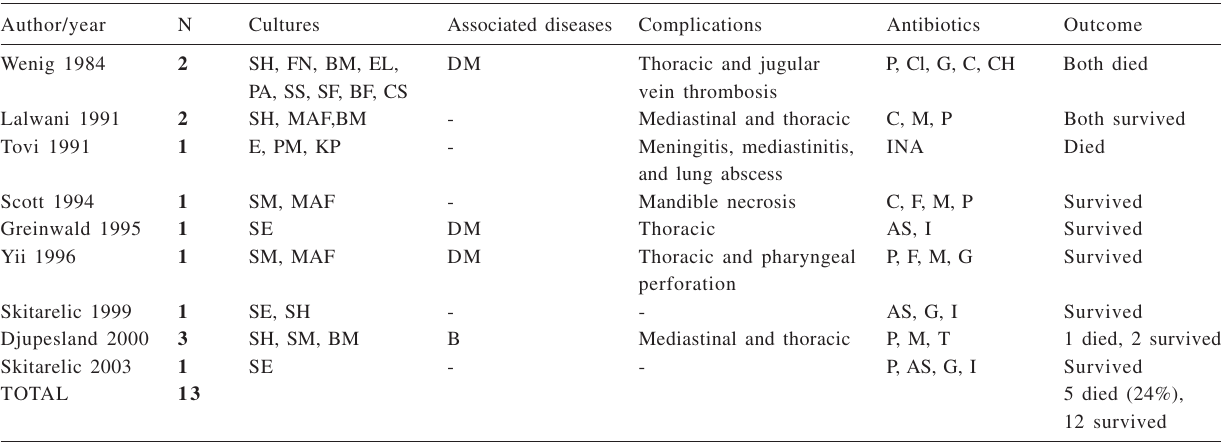
Table 1 - Review of all cases found in literature 8